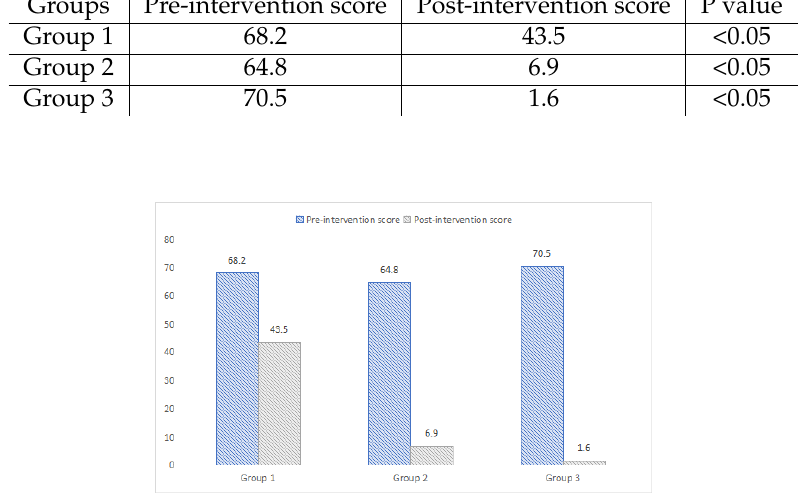
Figure 1. Graphical comparison of foot function index